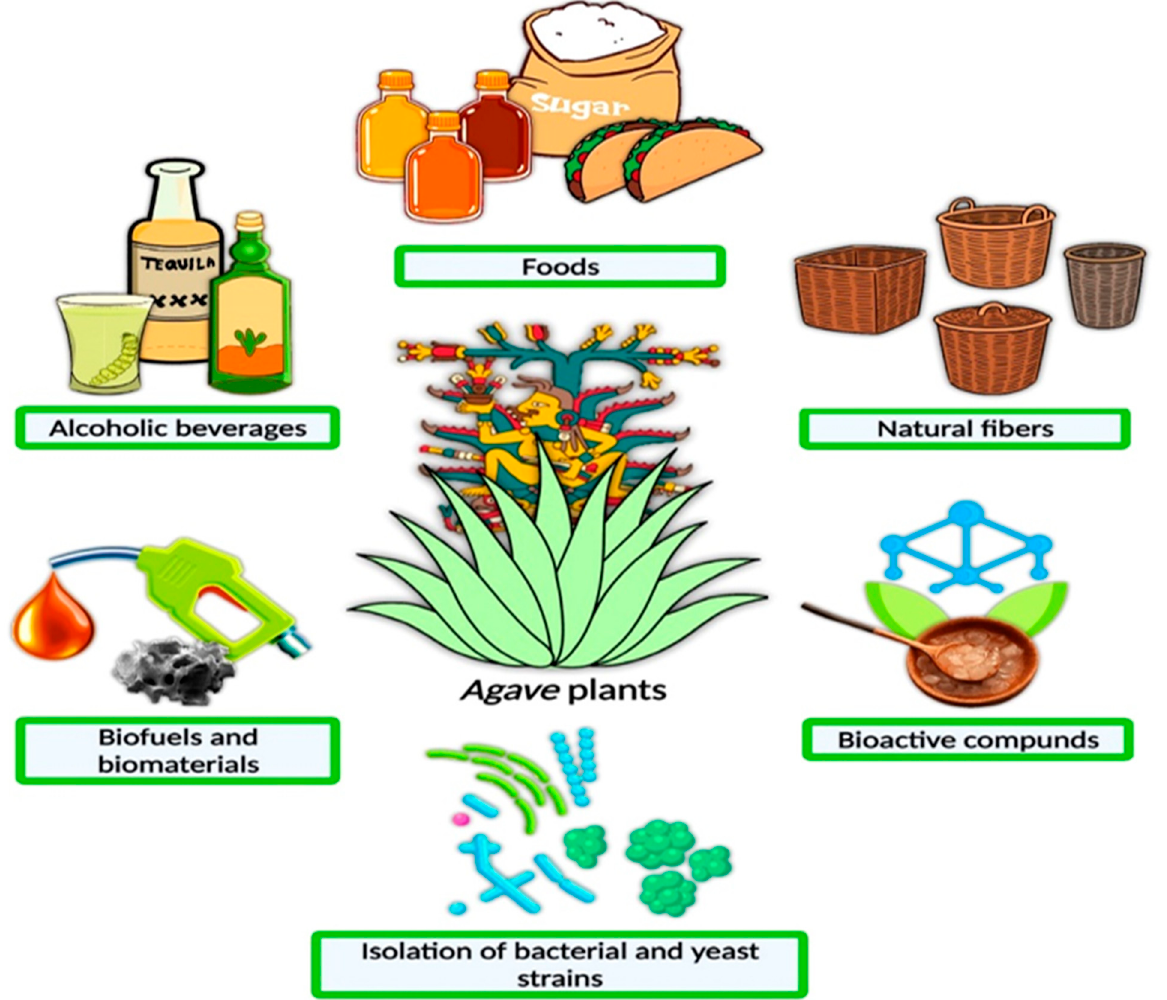
Figure 1. Produce acquired from agave plants [22] (Reprinted with permission from Ref. [22]. Copyright 2021 Elsevier).